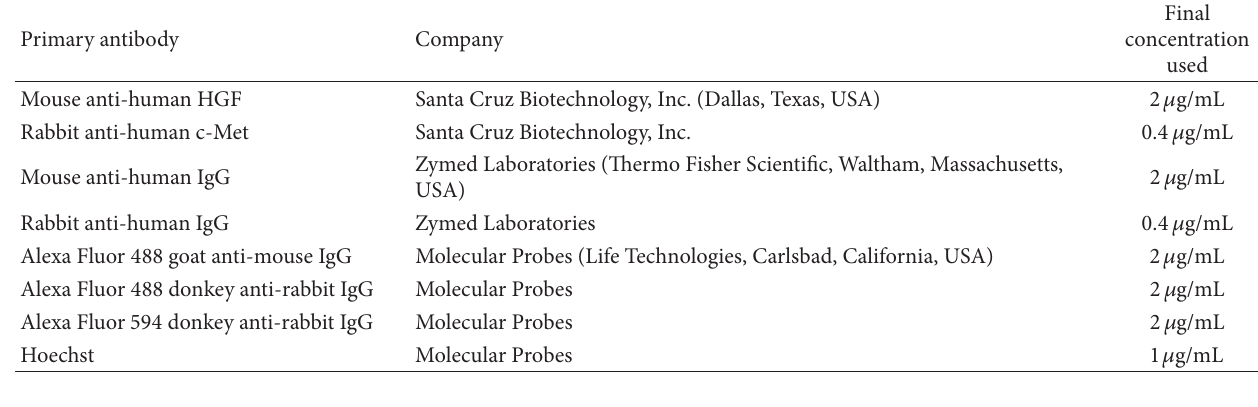
Table 3: Primary antibodies and negative controls used for immunostaining.